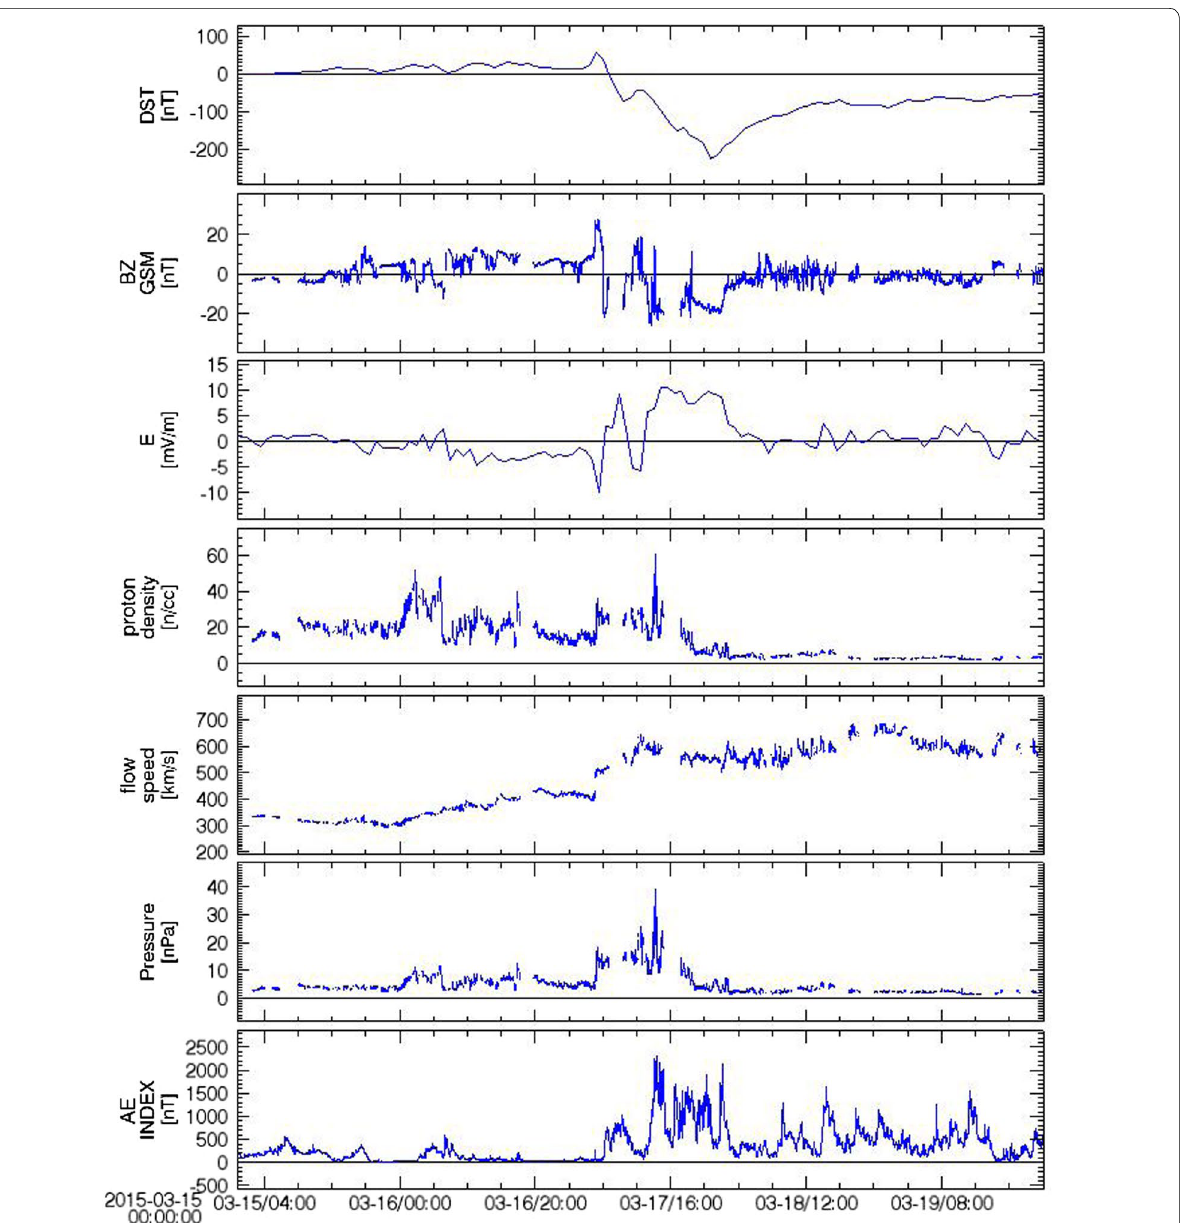
Fig. 1 From top to bottom the parameters shown are Dst index, B z magnetic field (nT), E electric field (mV/m), proton density N (1/cm 3 ), solar wind dynamic pressure P (nPa), flow speed v (km/s) and auroral electrojet AE (nT) index for March 15–19, 2015 (from NASA NSSDC OMNI data set). The characteristic storm at the intense level (Dst 223 nT) on March 17, 2015, has been analyzed. Figure 1 shows the OMNI data set from 00 UT March = − 15, 2015, to 00 UT March 19, 2015. The plot interval covers the storm day (March 17, 2015), 2 days before and 2 days after (120 h) the